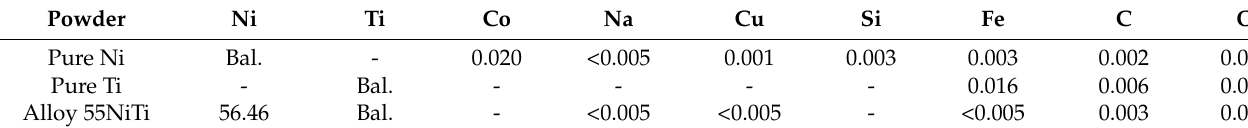
Table 1. The nominal composition of the powders ( wt %).